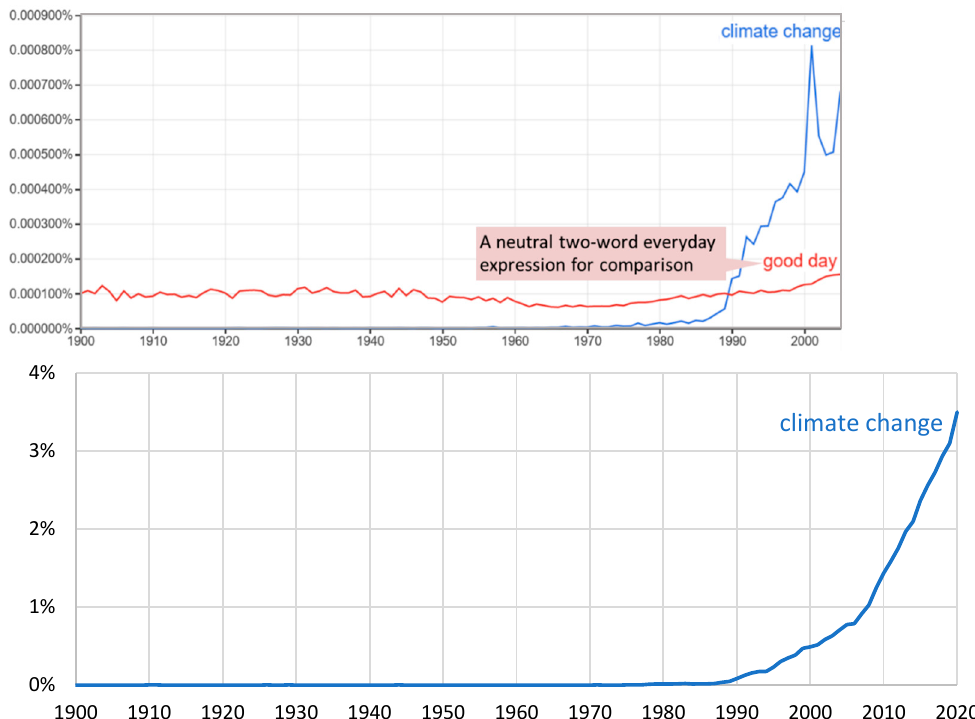
Figure 8. Evolution of the frequency of appearance of the term “climate change”: ( upper ) in the millions of books archived by Google Books (the neutral term “good day” is used as a reference for comparison, and it appears that after 1990 “climate change” became more important than “good day”); ( lower ) in the 78 million items contained in the Scopus database of scientific articles (the search was conducted over “all fields”).